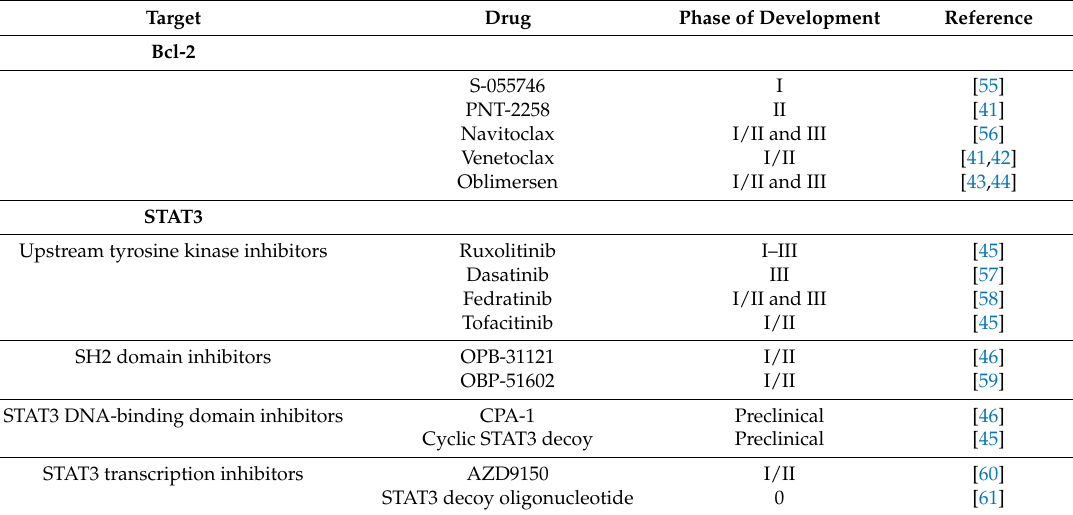
Table 2. Oncogenes linked to IH and the drugs that inhibit these